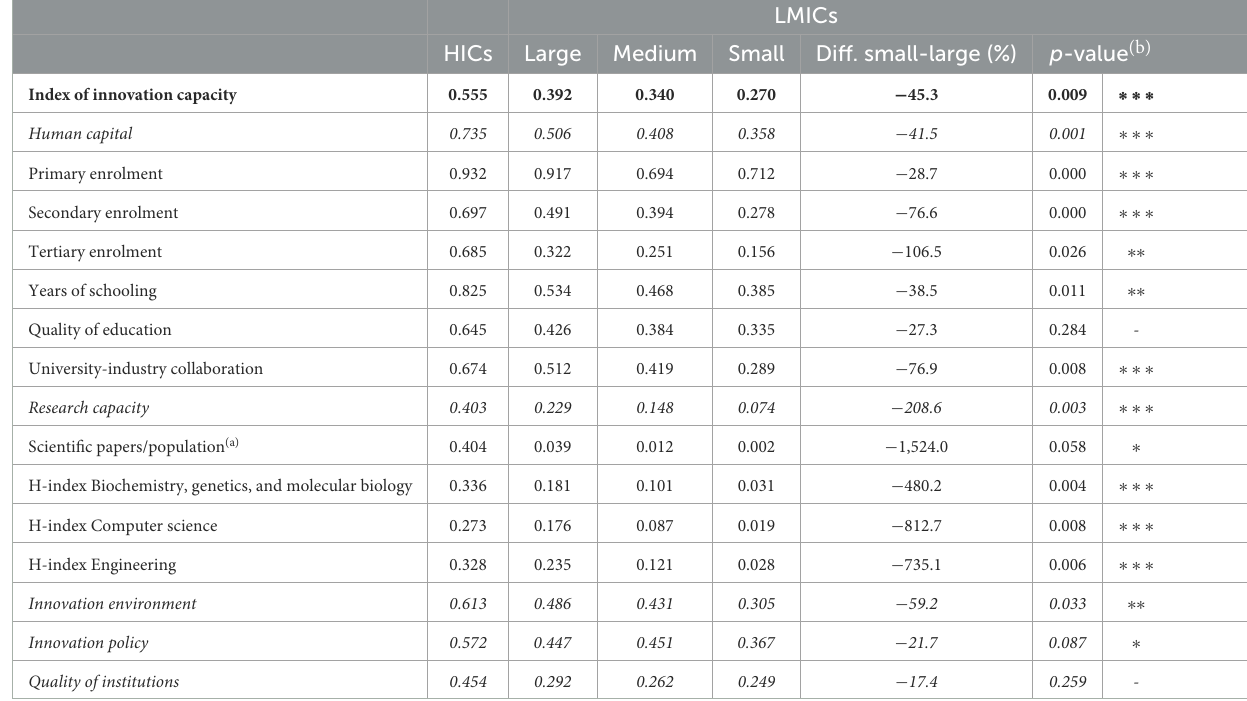
TABLE 3 The index of innovation capacity (IIC) and its components for HICs and LMICs grouped by the size of their agricultural research systems, average values for